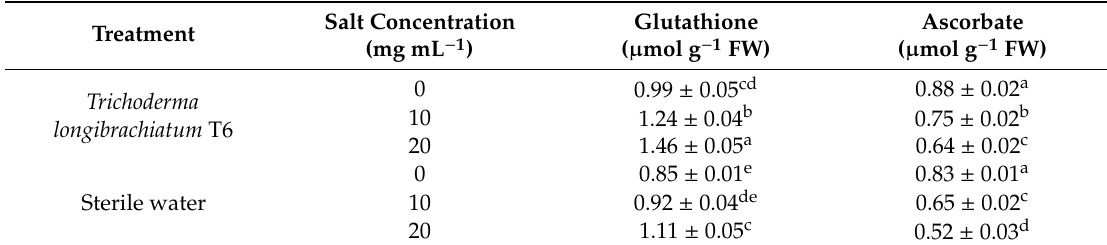
Table 4. E ff ect of Trichoderma longibrachiatum T6 on the contents of glutathione and ascorbate in wheat seedling leaves under salt